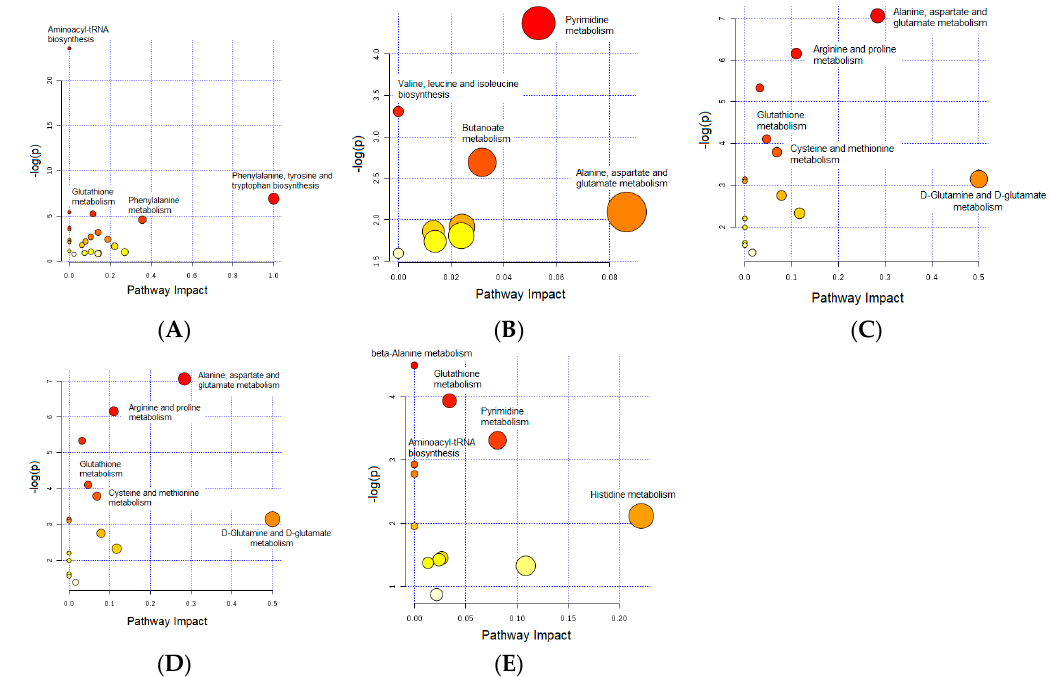
Figure 7. Pathway analysis of the positively identified and significantly altered metabolites in the ( A ) rat brain, ( B ) heart, ( C ) kidney, ( D ) liver, and ( E ) skeletal muscle tissues after prolonged treatment with dexamethasone. The size and color of each circle were based on the pathway impact value and p ‐ value, respectively.